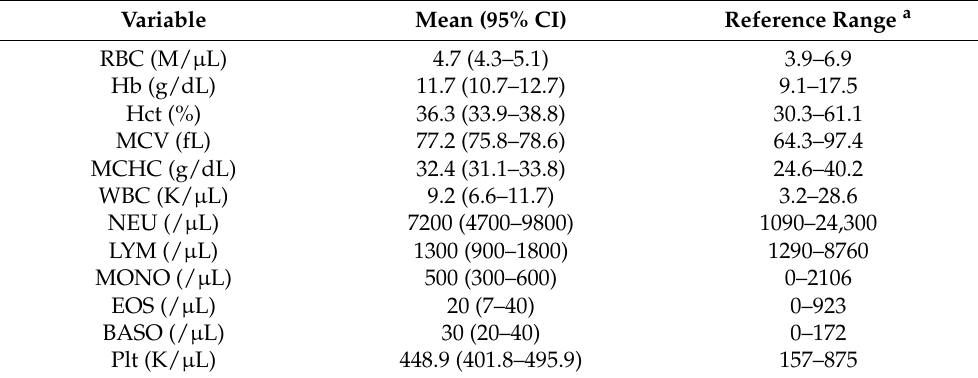
Table 1. Complete blood count (CBC) (mean and 95% confidence interval, CI) in 11 baboons ( Papio hamadryas ) 15 min after intramuscular injection with tiletamine-zolazepam and medetomidine.